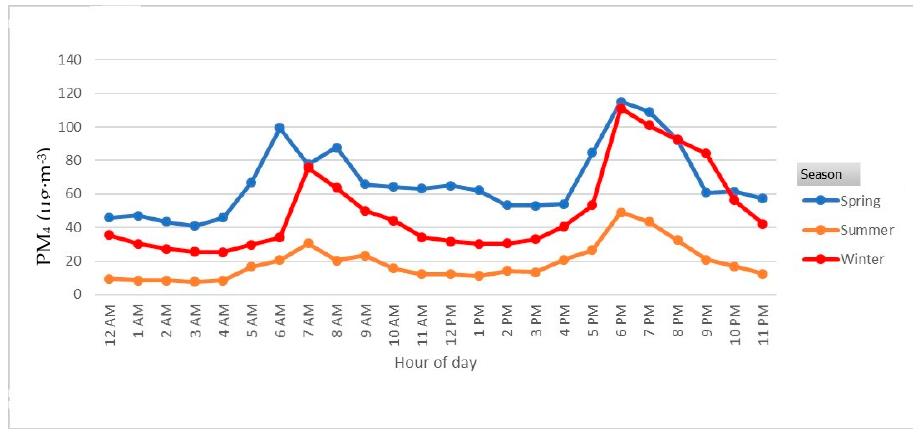
Figure 6. Diurnal time series of average hourly PM 4 concentrations by time of day and season.